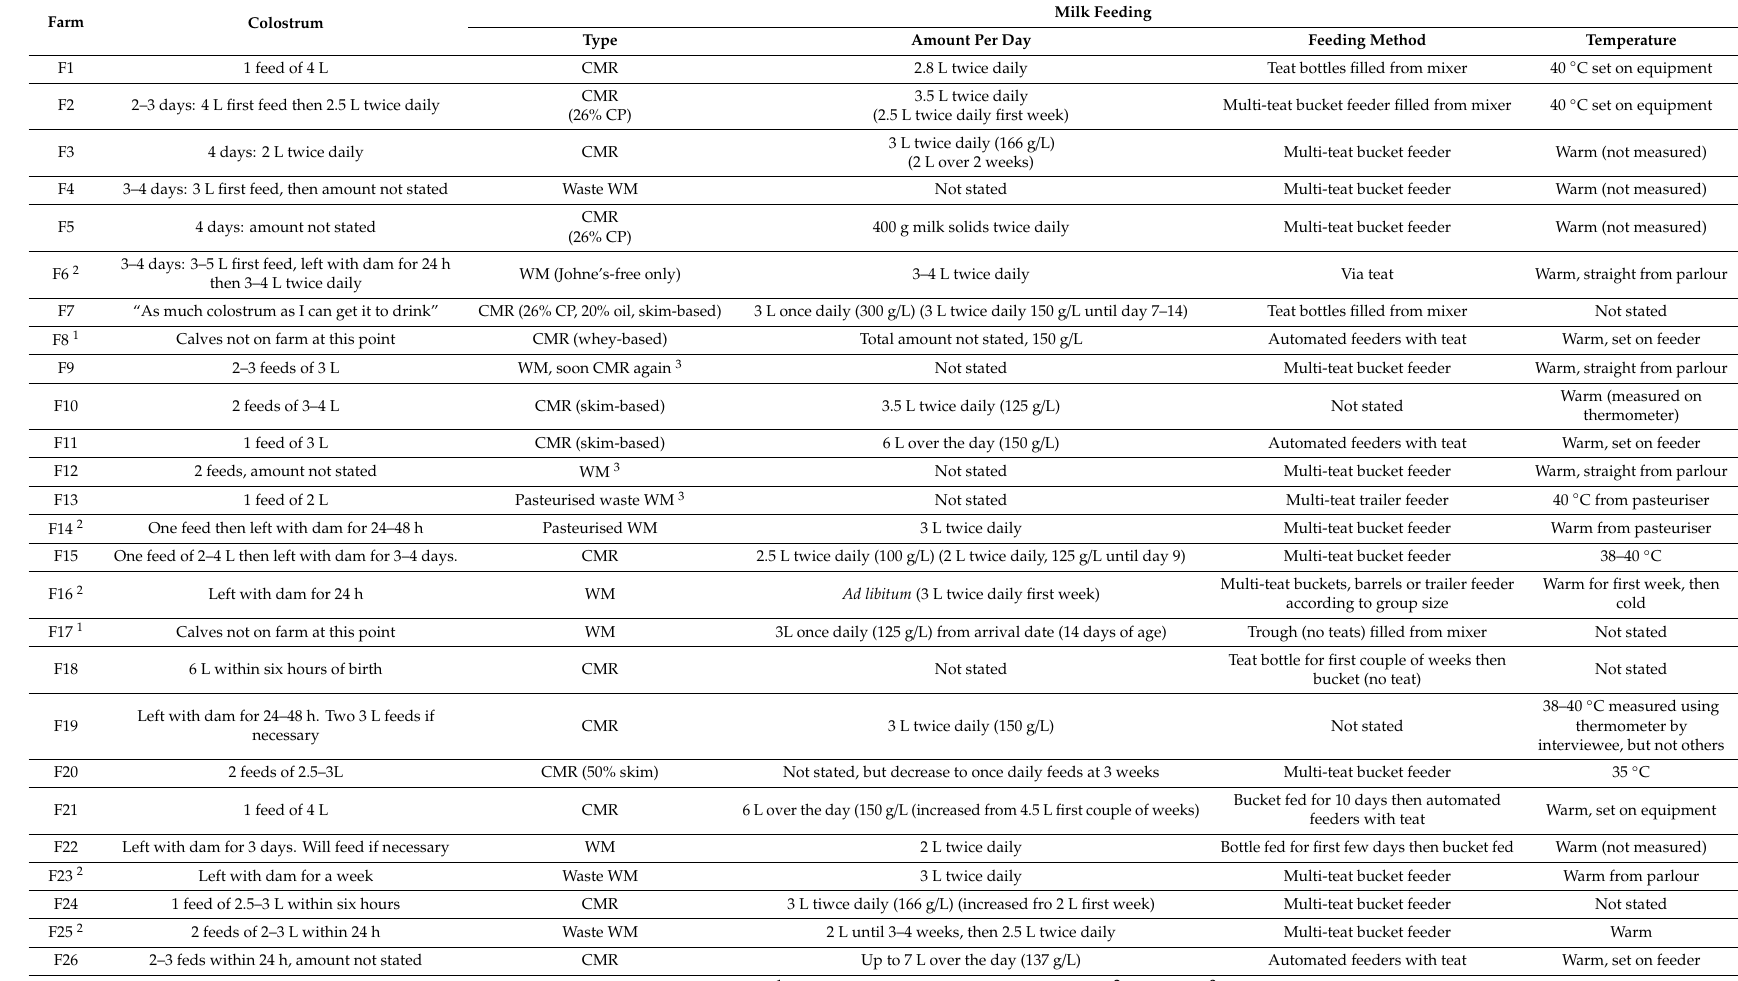
Table 3. Information given by farmer participants regarding heifer calf milk